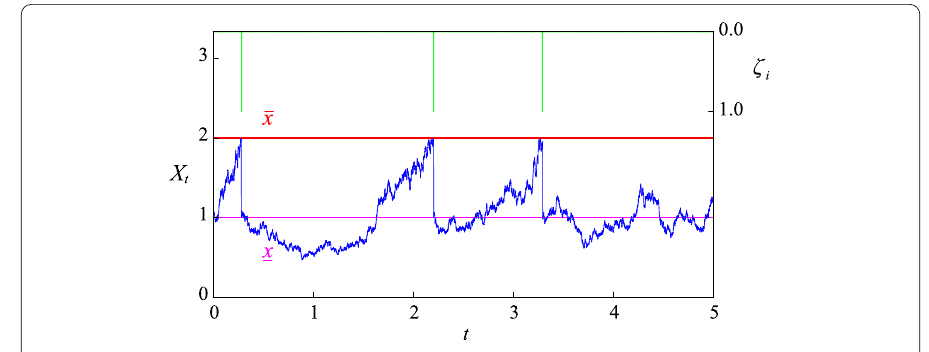
Figure 1 The process X t under the optimal management policy is blue line. The thresholds are ¯ x = 2 (red line) and x = 1 (pink line). The optimal magnitude of the killed animal ζ i is shown as green